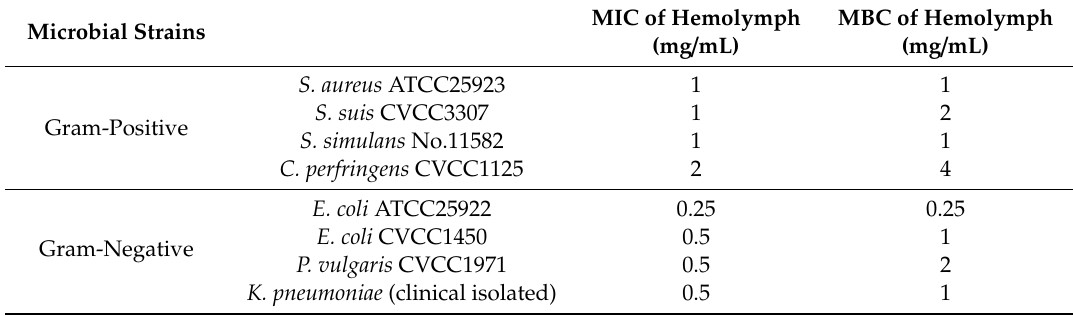
Table 1. Minimum inhibitory concentration (MIC) and minimum bactericidal concentration (MBC) values of Z. morio antimicrobial